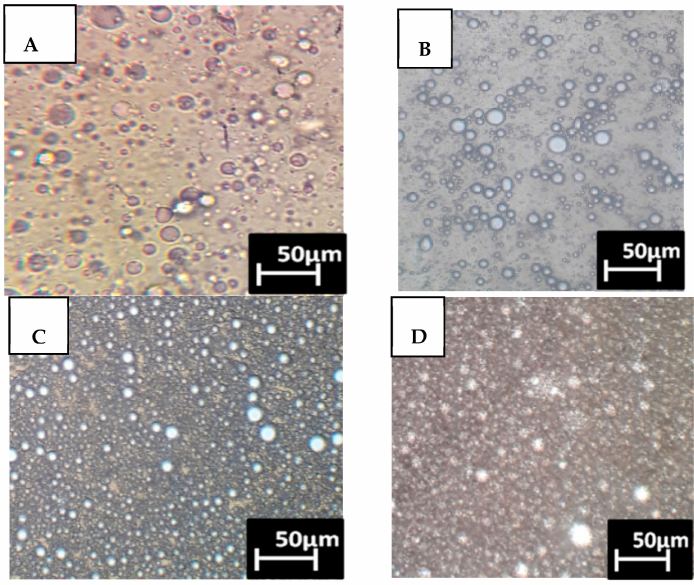
Figure 2. Microscopic observations of the droplets that were formed from the bioemulsifier: ( A ) Metabolic liquid at 24 h; ( B ) Metabolic liquid at 48 h; ( C ) Metabolic liquid at 72 h; ( D ) Metabolic liquid at 96